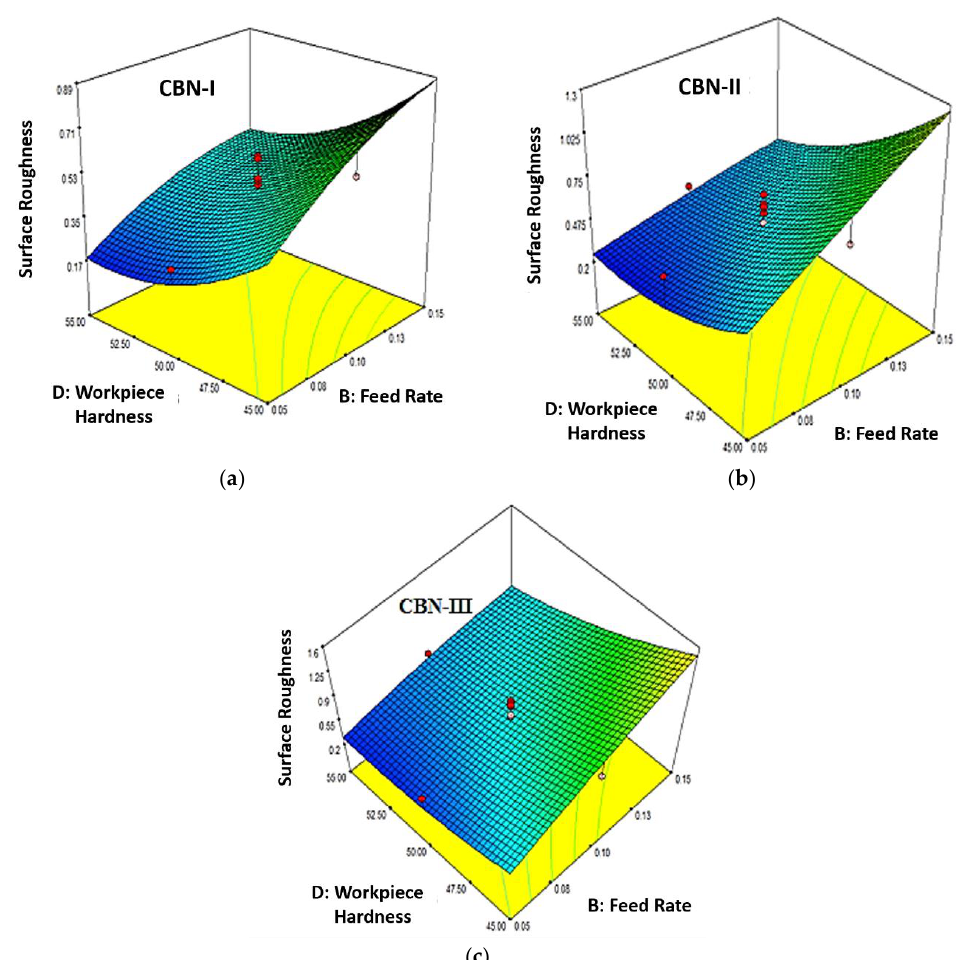
Figure 3. ( a ) Effect of Feed Rate (B) and Work Material Hardness (D) on Surface Roughness (R a ) for CBN-I insert ( b ) Effect of Feed Rate (B) and Work Material Hardness (D) on Surface Roughness (R a ) for CBN-II insert ( c ) Effect of Feed Rate (B) and Work Material Hardness (D) on Surface Roughness (R a ) for CBN-III insert.